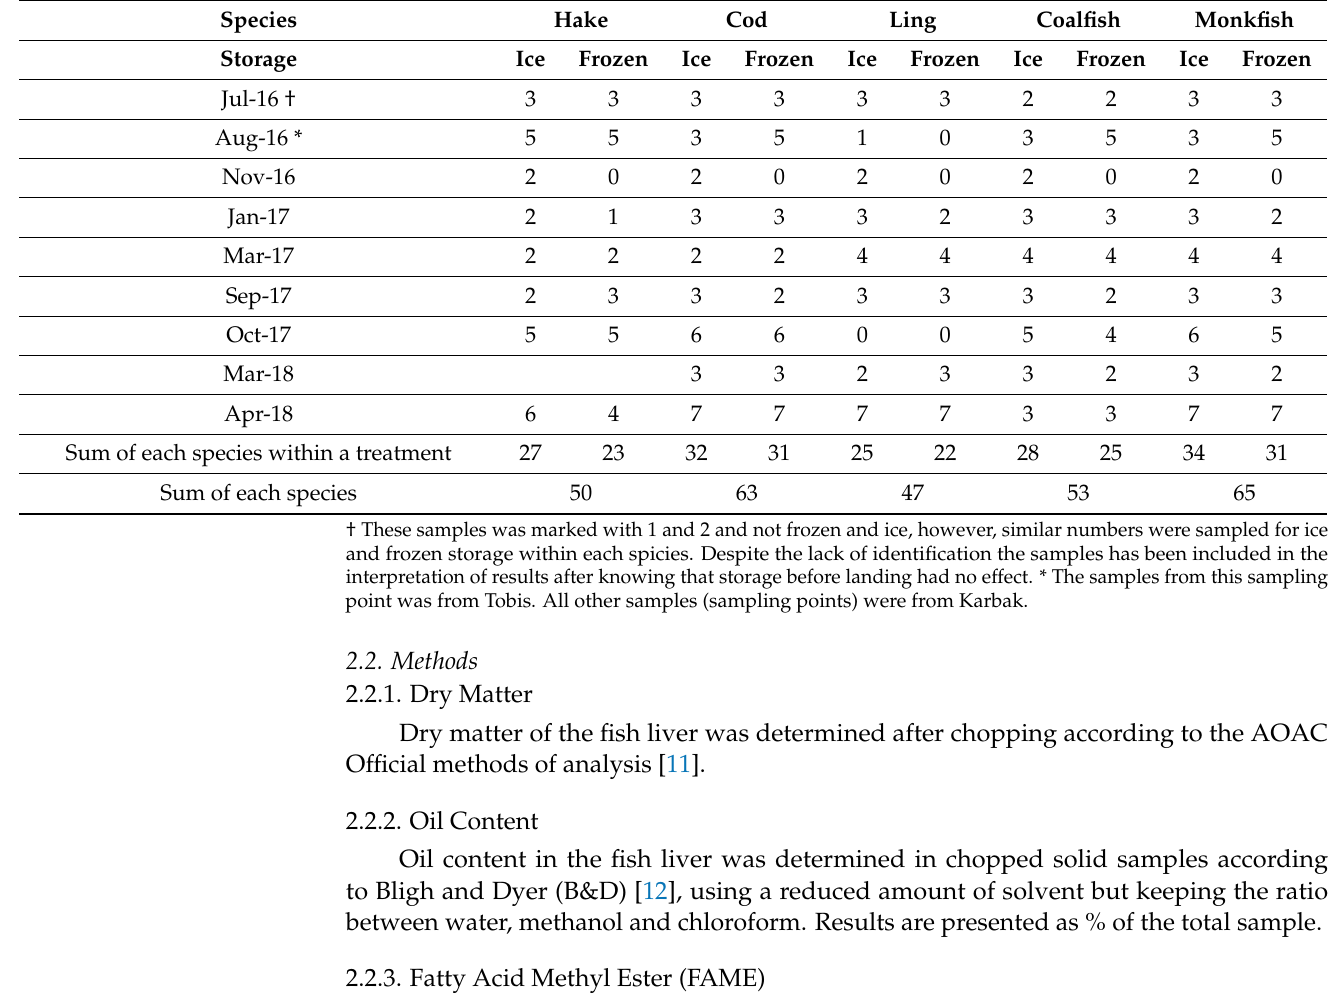
Table 1. Number of samples received at different sampling times for each species and treatment. Species Hake Storage